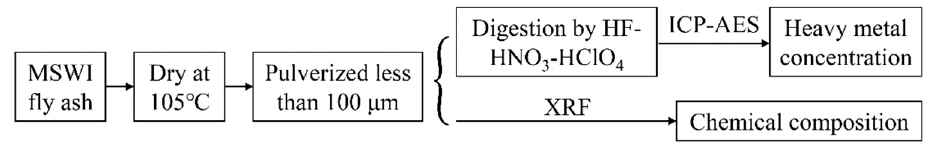
Figure 1. Schematic of the preparation of the MSWI fly ash. Table 1. Chemical composition of MSWI fly ash, %.